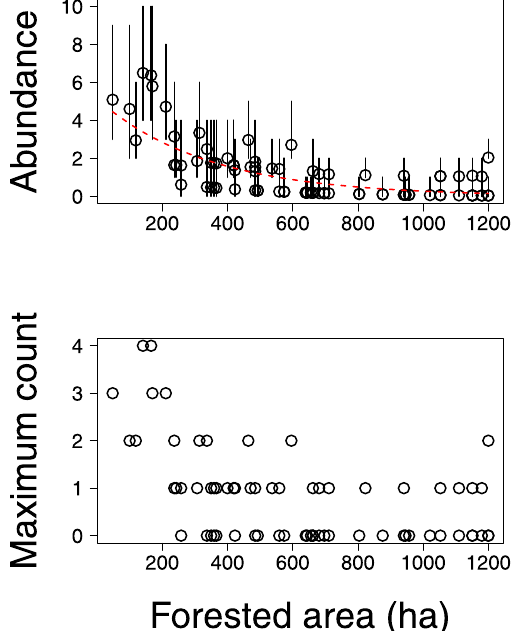
Figure 4. Maximum observed count of catbirds and estimates of their abundance (posterior means and 95% credible intervals) at sample locations. Dashed line indicates the estimated relationship between mean abundance of catbirds and forested area.